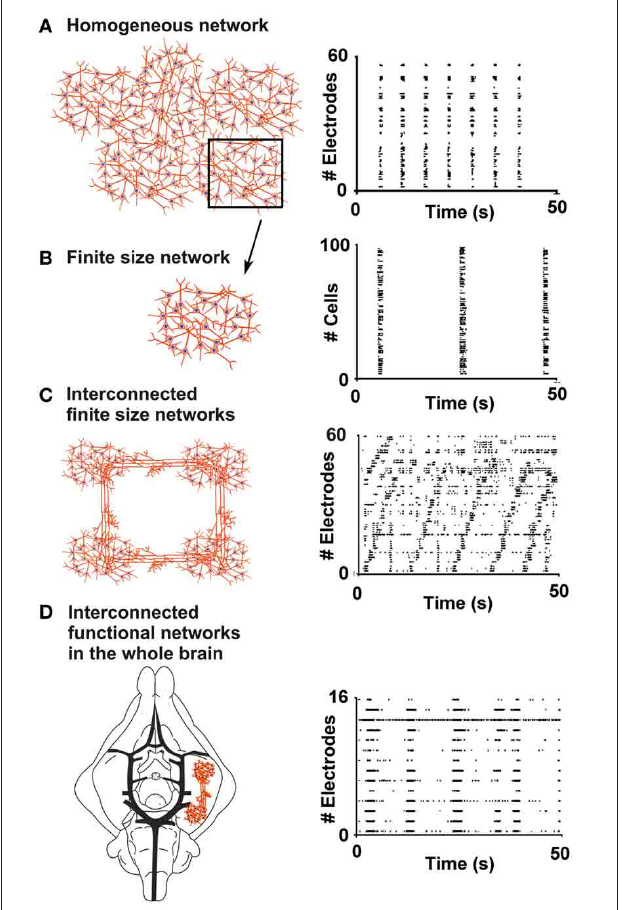
FIGURE 1 | From finite size networks up to the whole brain: a bottom-up approach. (A) Sketch of a homogeneous network composed of about 1000 neurons (left panel) and the typical raster plot of its electrophysiological activity, recorded by using 60 electrodes of a Micro Electrode Array (MEA) chip (right panel). The black box highlights a sub-region of the homogeneous network, which can be described as a finite size network (black arrow pointing to panel B ). (B) Sketch of a finite size network used in the framework of this paper, composed of about 100 neurons (left panel), and its raster plot, obtained by calcium imaging recording (right panel). (C) Scheme of interconnected finite size networks, each composed of about 100 neurons (left panel), and the raster plot of the electrophysiological activity recorded by a MEA (right panel). (D) Sketch of the in-vitro whole brain of a guinea pig composed by interconnected functional networks (left panel), and raster plot of the spontaneous periodic events recorded by an array of 16 electrodes (right